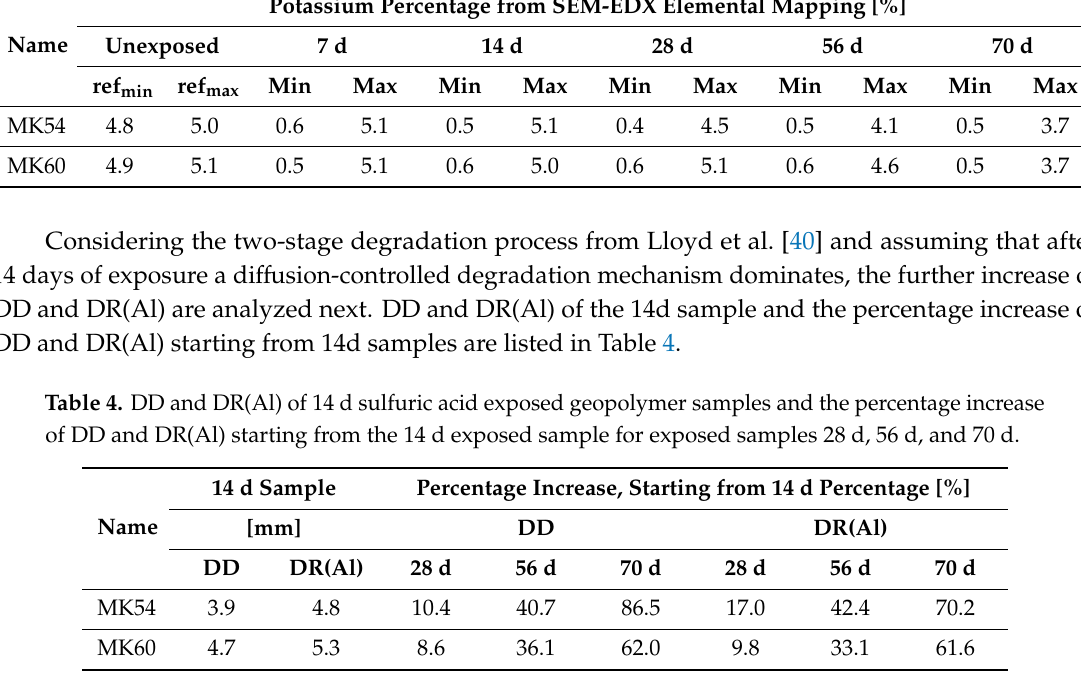
Table 3. Minimum and maximum potassium percentage of unexposed and sulfuric acid exposed samples, from SEM-EDX elemental mapping.